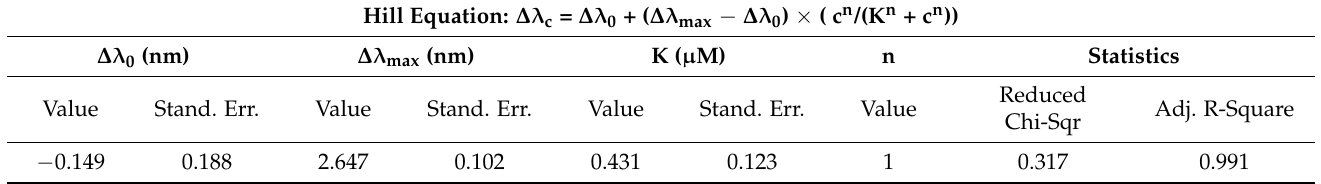
Table 2. Chemical parameters for bovine serum albumin (BSA) detection. Table 3. Hill parameters of SARS-CoV-2 Spike protein detection.